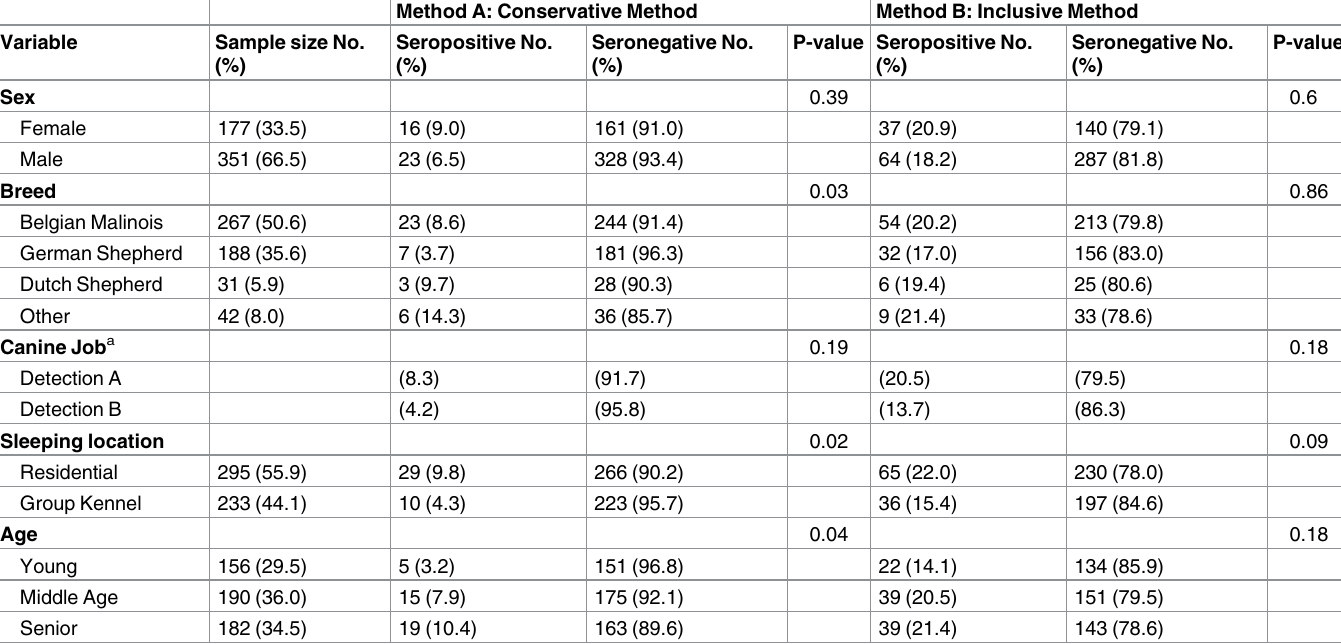
Table 1. Results of bivariable analysisof potential risk factorsfor seropositive government working dogs (defined by method A and B) in five man- agement areas and training center along the Texas-Mexico border, 2015–2016.